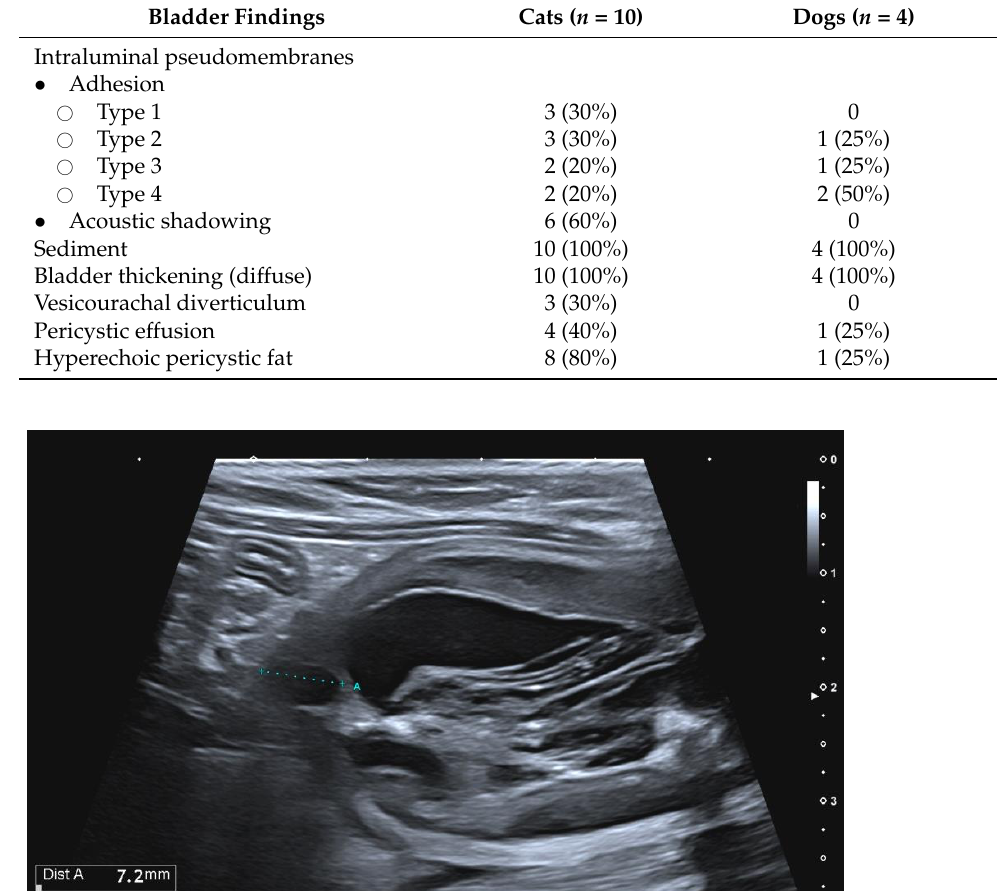
Table 2. Abnormal ultrasound findings for the urinary bladder and pericystic peritoneal space in all patients.